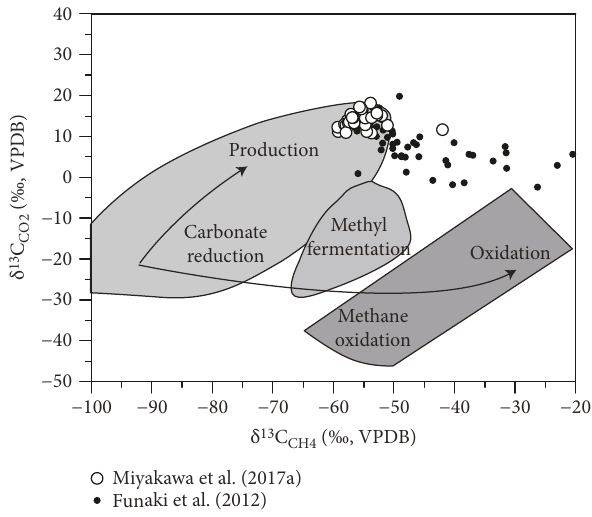
Figure 1: Plot of δ 13 C vs. δ 13 C in coexisting gases, showing CH4 CO2 fi elds relating to di ff erent gas sources and isotopic shifts resulting from production and oxidation (adapted from [50]). The data are from Funaki et al. [14] and Miyakawa et al.